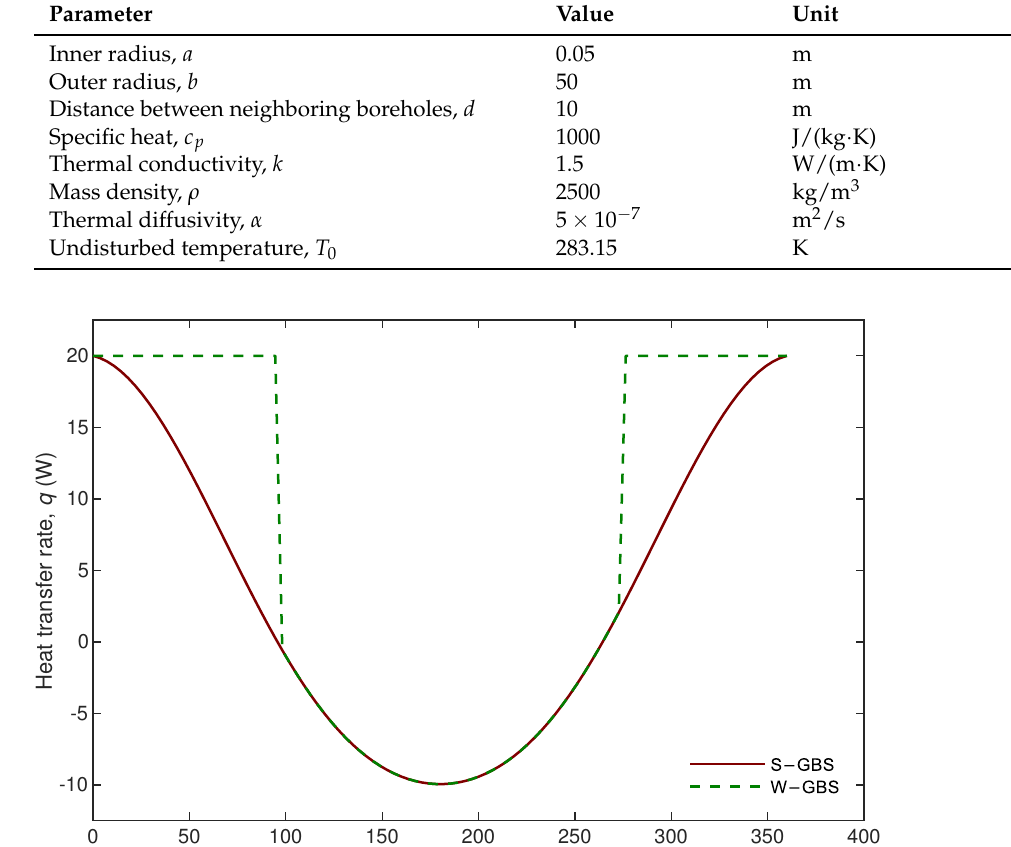
Table 1. Prescribed geometrical and thermophysical parameters of the ground. The listed values of parameters are consistent with the work [39].